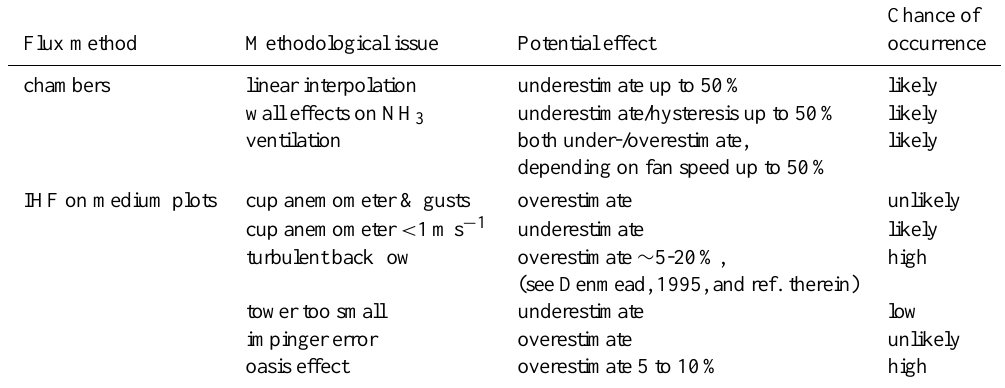
Table 1. Summary of methodological issues and their potential bias effects on different NH 3 flux measurement